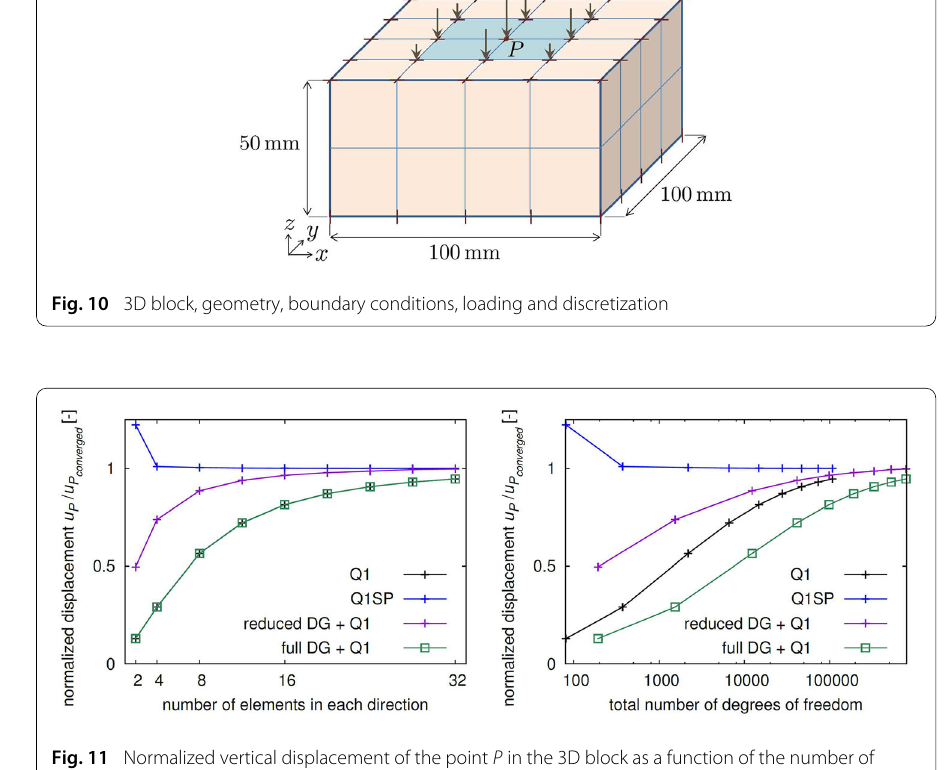
ber of elements (left) and once with respect to the number of degrees of freedom (right) is